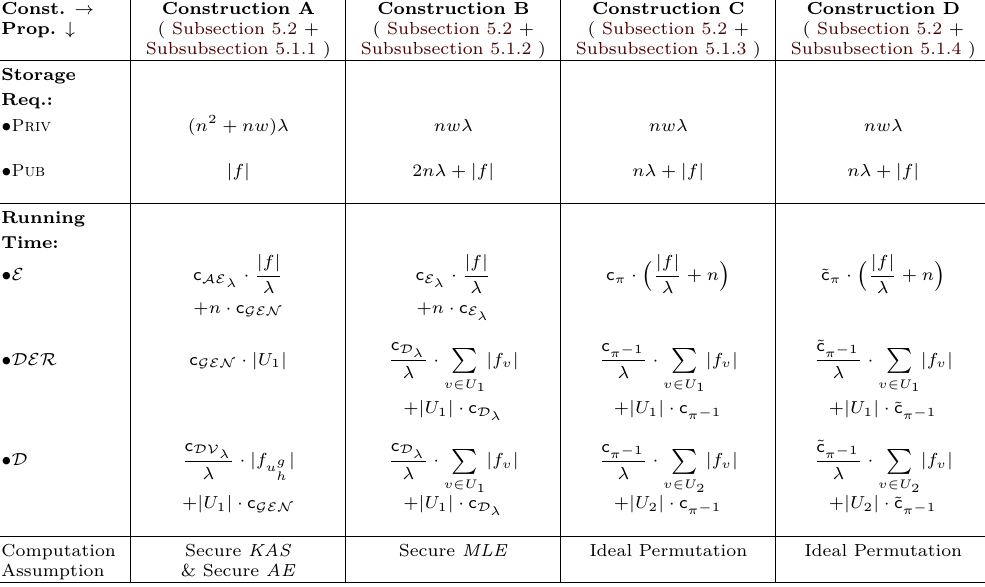
Table 2: Comparison table for different KAS-AE schemes built using KAS-AE-chain con- structions (described in Subsection 5.1) embedded into modified chain partition algorithm (described in Subsection 5.2). Const. →